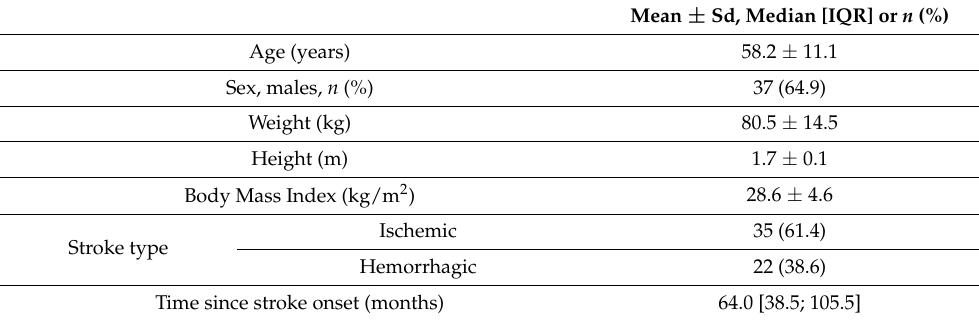
Table 1. Participants ‘demographic and clinical characteristics ( n =